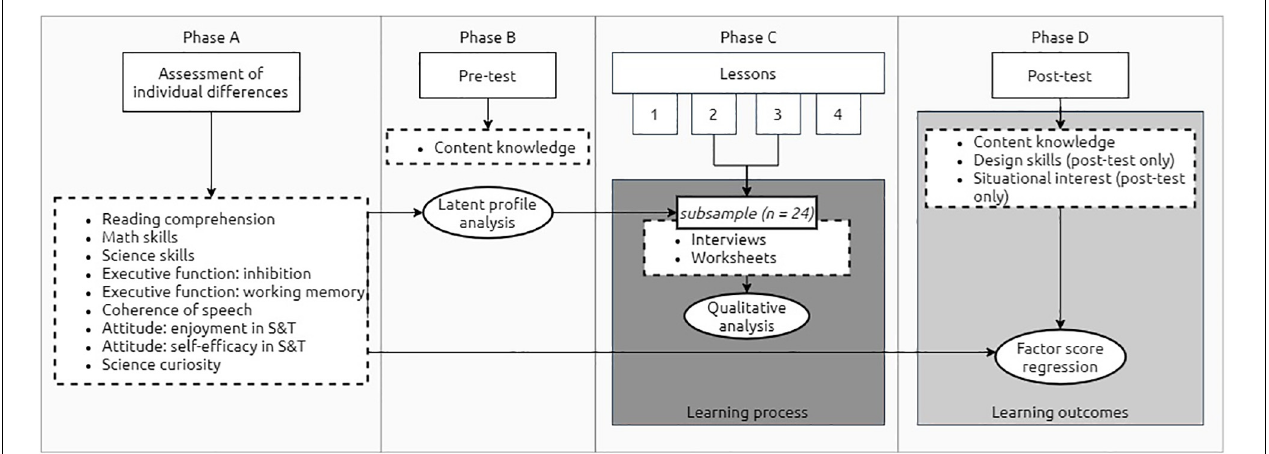
FIGURE 1 | Research